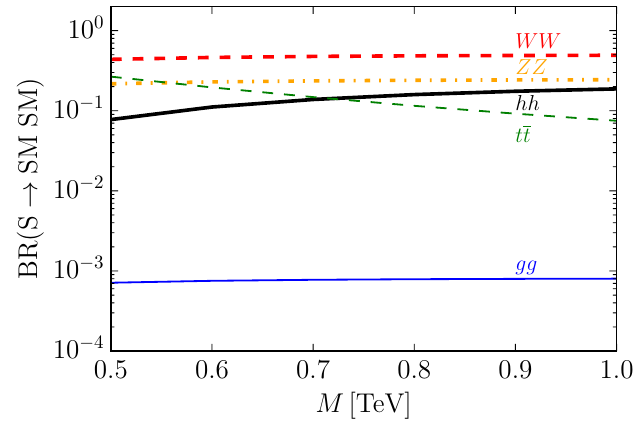
Figure 2 . Main S branching ratios as a function of the mass for the PNGB scalar (in the pseudo- scalar scenario, S decays almost exclusively into a pair of t quarks). We have assumed g (cid:26) = 4 (cid:25) and all k i couplings (cid:12)xed to the unit. Note that f and m (cid:26) can then be obtained from the expressions in table